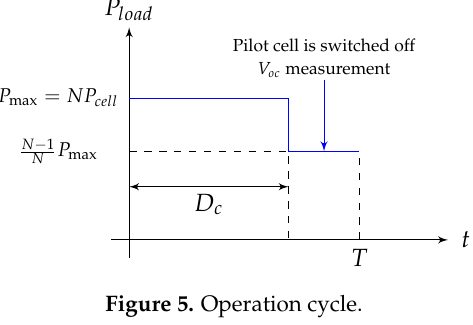
Figure 5. Operation